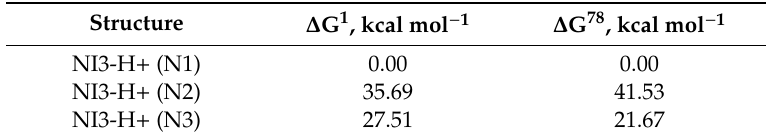
Figure 9. Hirshfeld charges on N-atoms, calculated for the molecular structure of NI3. Table 4. Relative stabilities of the protonated NI3 forms in the gas-phase (superscript 1) and in water (superscript 78).